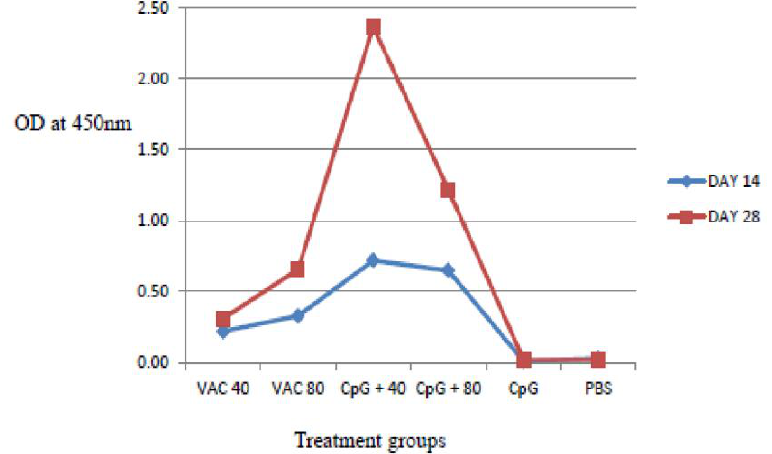
Figure 3. IgG antibody response to SARS-CoV-2 using ELISA assays on days 14 and 28. The IgG response was significantly stronger in the 4 × 10 9 VP of vaccine supplemented by CpG ODNs mice, compared to the CpG ODNs and 8 × 10 9 VP of vaccinated mice ( p < 0.06).